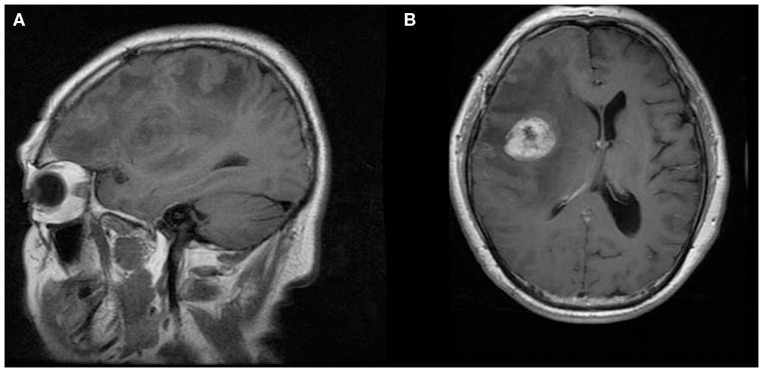
A 70-year-old man with supratentorial intraparenchymal anaplastic ependymoma in the right frontal lobe on (A) T1-weighted image and (B) contrast T1-weighted image. The tumor appears as heterogeneous signal intensity and marked peritumoral edema.